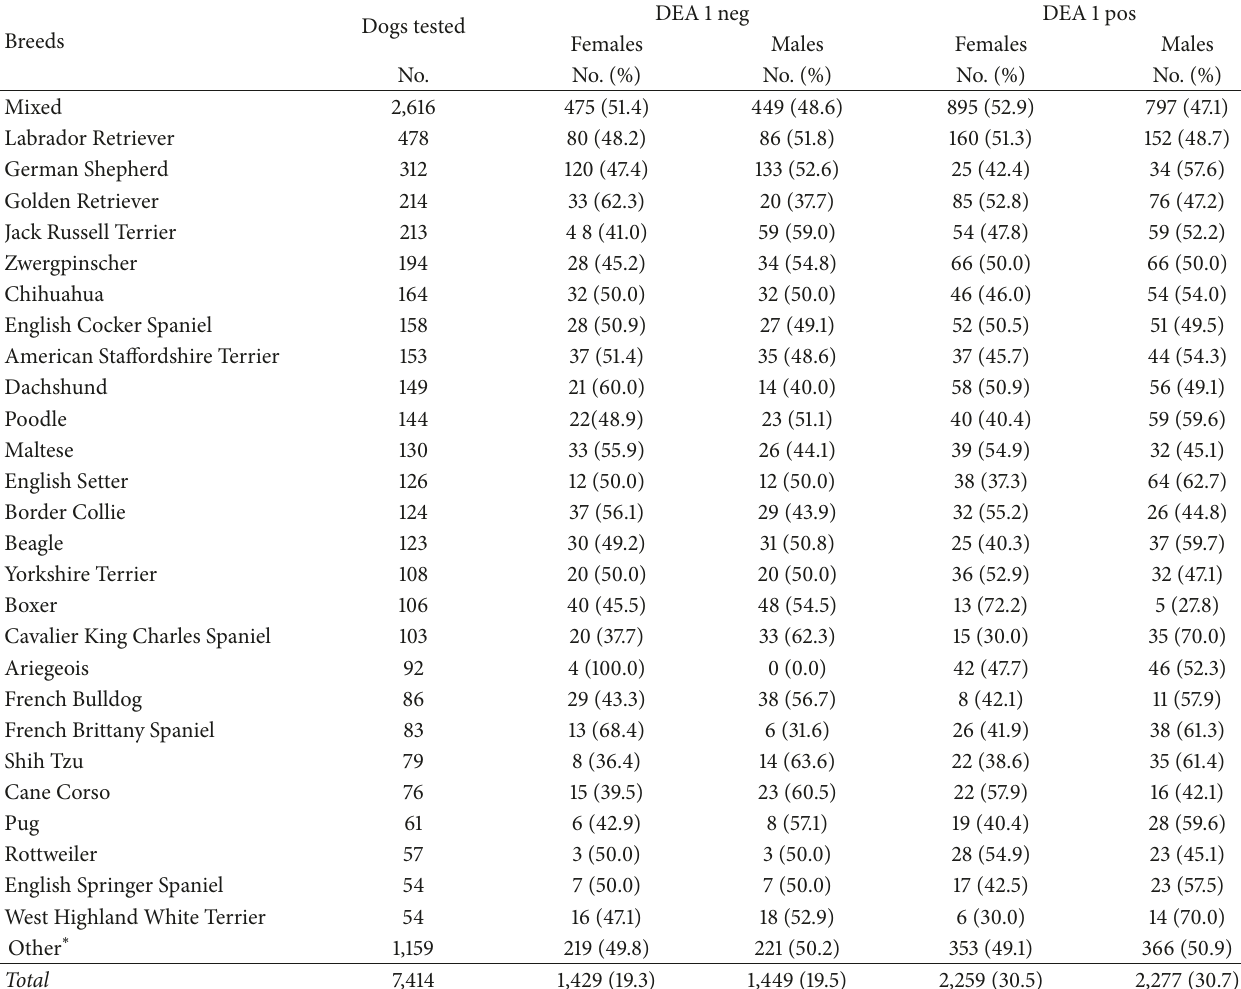
Table 2: Prevalence of DEA 1 negative and positive in female and male